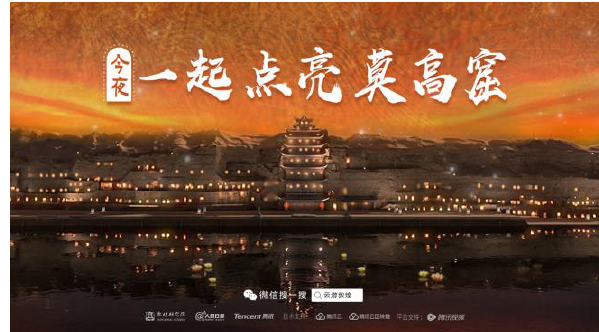
Figure 3 . Light Up the Mogao